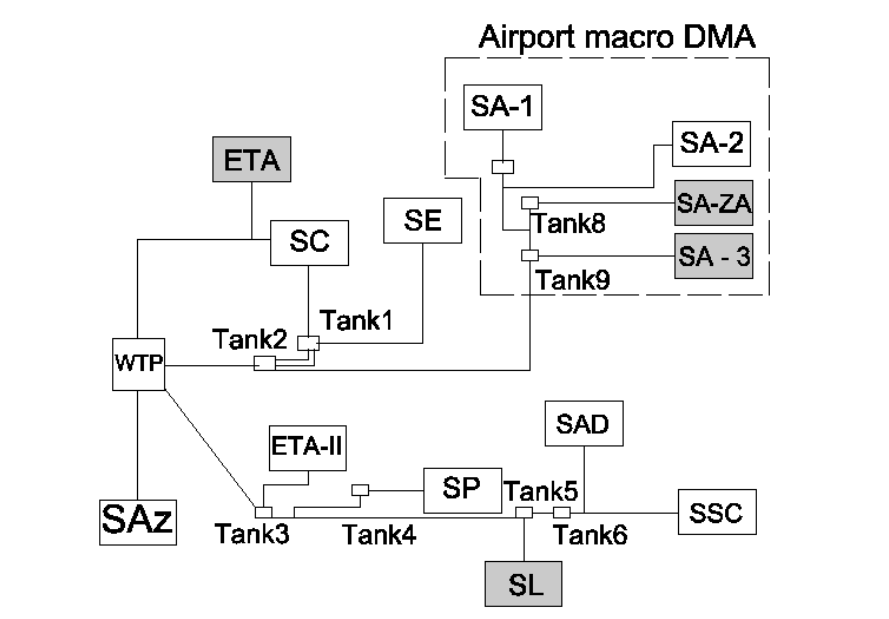
Figure 5. DMA layout of Franca’s